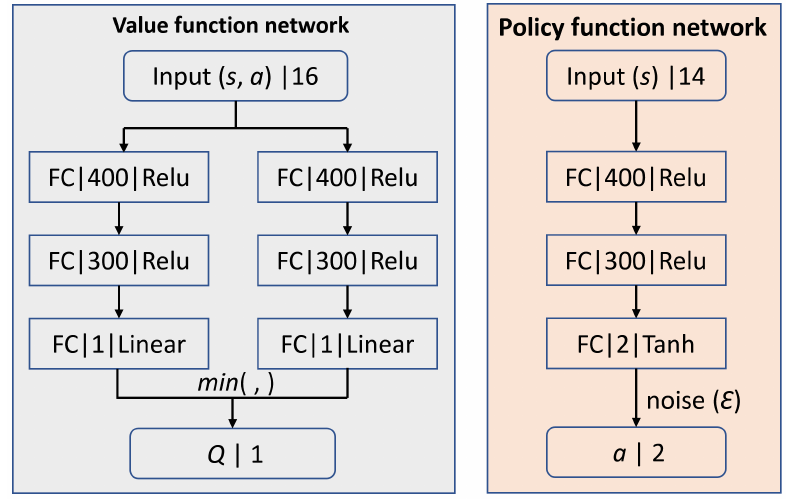
Figure 8. The TD3